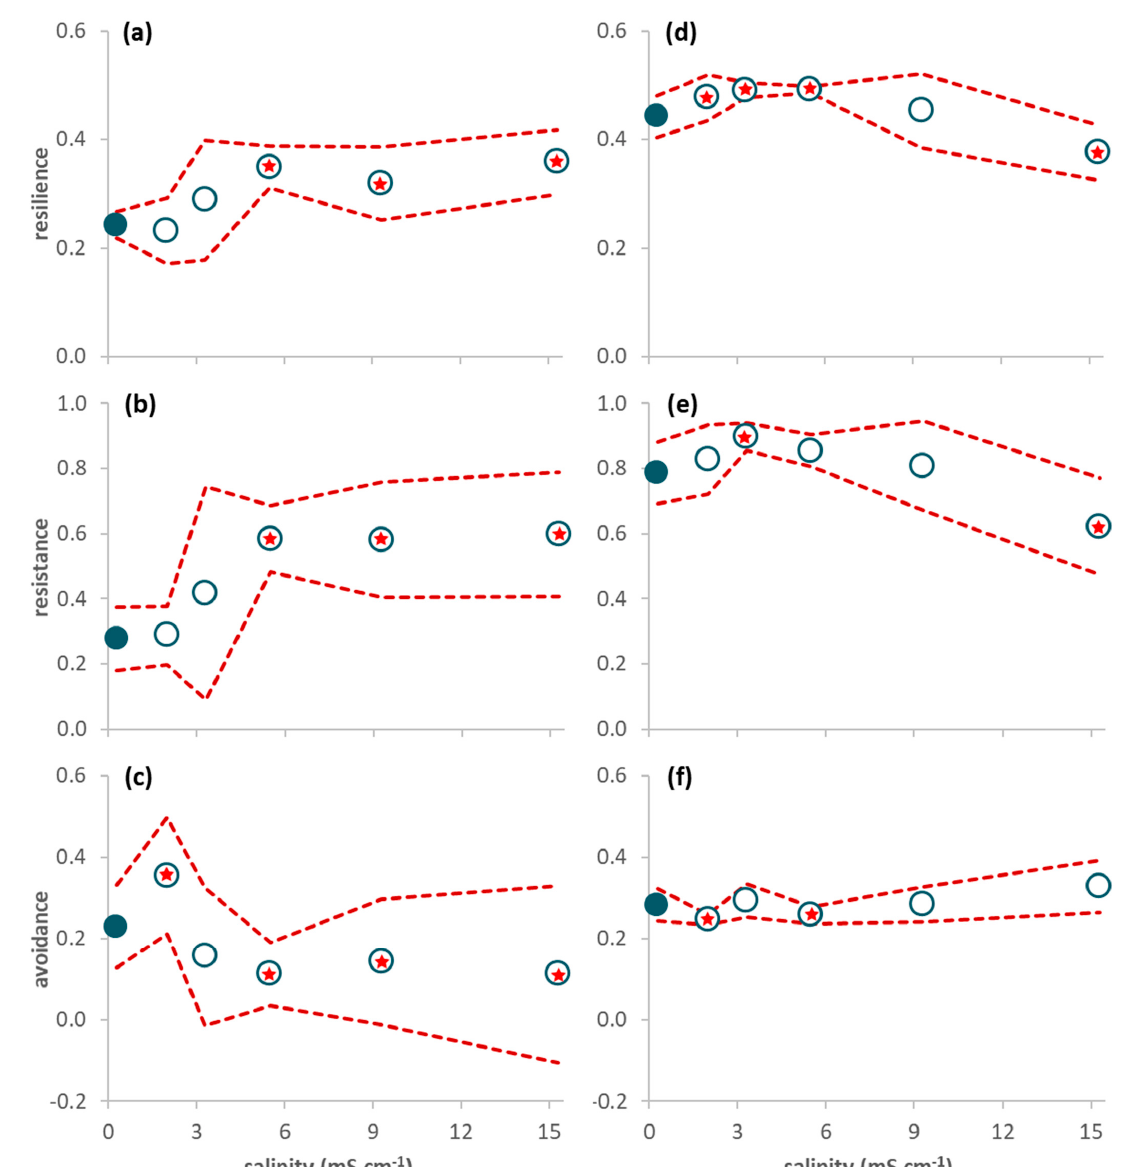
Figure 2. Proportion of traits (average per leaf pack ( a – c ) or average per sample ( d – f ) ± 95% confidence limits (red dashed line); n = 3) of invertebrates associated with decomposing leaf litter on day 63 ( a – c ) and sampled in the mesocosms during the period 21–65 days after seawater intrusion ( d – f ). ( a , d ) Resilience traits (short lifespan, ovoviviparous reproduction, and aerial respiration); ( b , e ) Resistance traits (multivoltinism); ( c , f ) Avoidance traits (non-aquatic life stages and terrestrial reproduction). A red star indicates a net average deviation of the values in a treatment (open circles) in relation to the values in the control (close circles) according to Table 2. 3.3. Invertebrate Coomunities in the Mesocosms There were no significant differences among the mesocosms in invertebrate abun- dance and richness before seawater intrusion (MANOVA: F 0.05(1)5,6 = 0.92, p = 0.53; Table S2 in Supplementary Materials); average abundance per mesocosm ranged from 15.0 ± 0.0